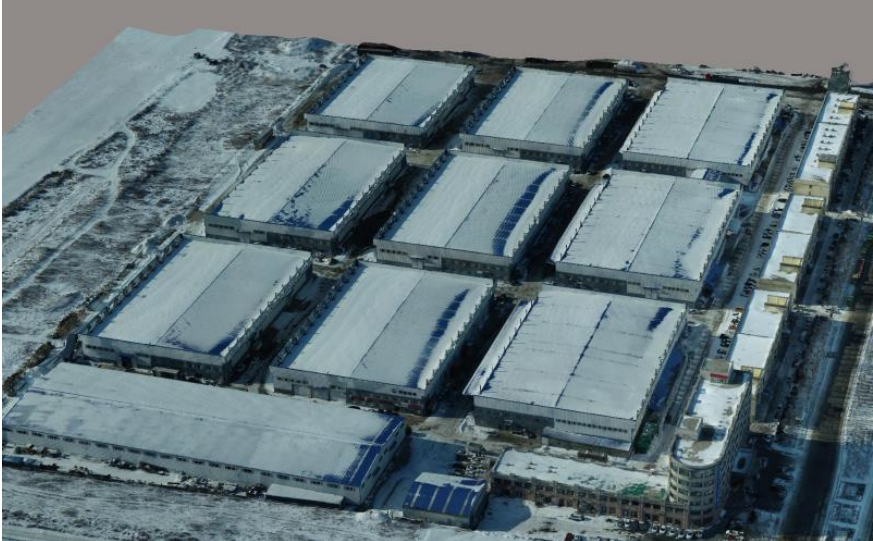
Figure 1. Three-dimensional model of snow distributions on a group of buildings in Harbin, China.